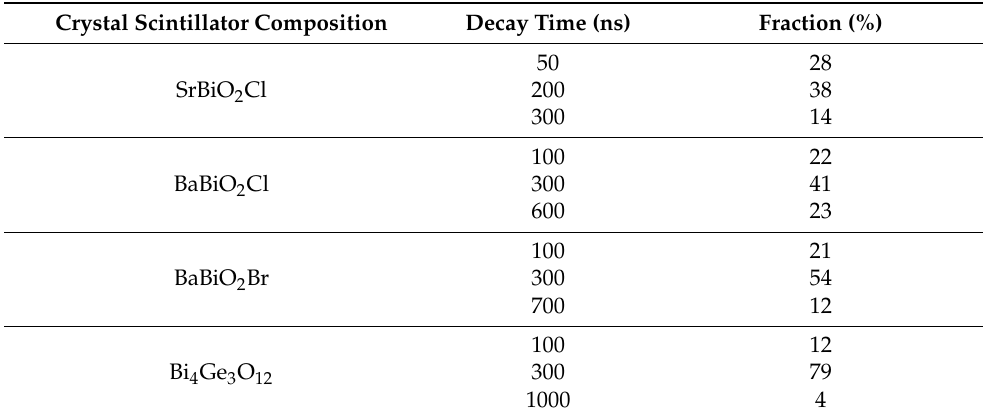
Table 4. Radio-luminescence decay constant and fractional contribution at RT. Reproduced from Reference [127] with